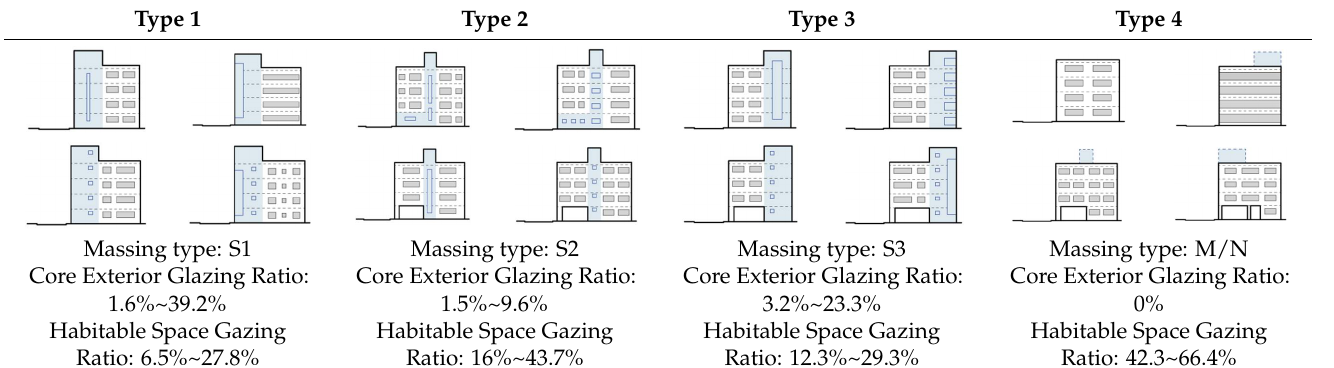
Table 3. Analysis of potential daylight access on south elevations.